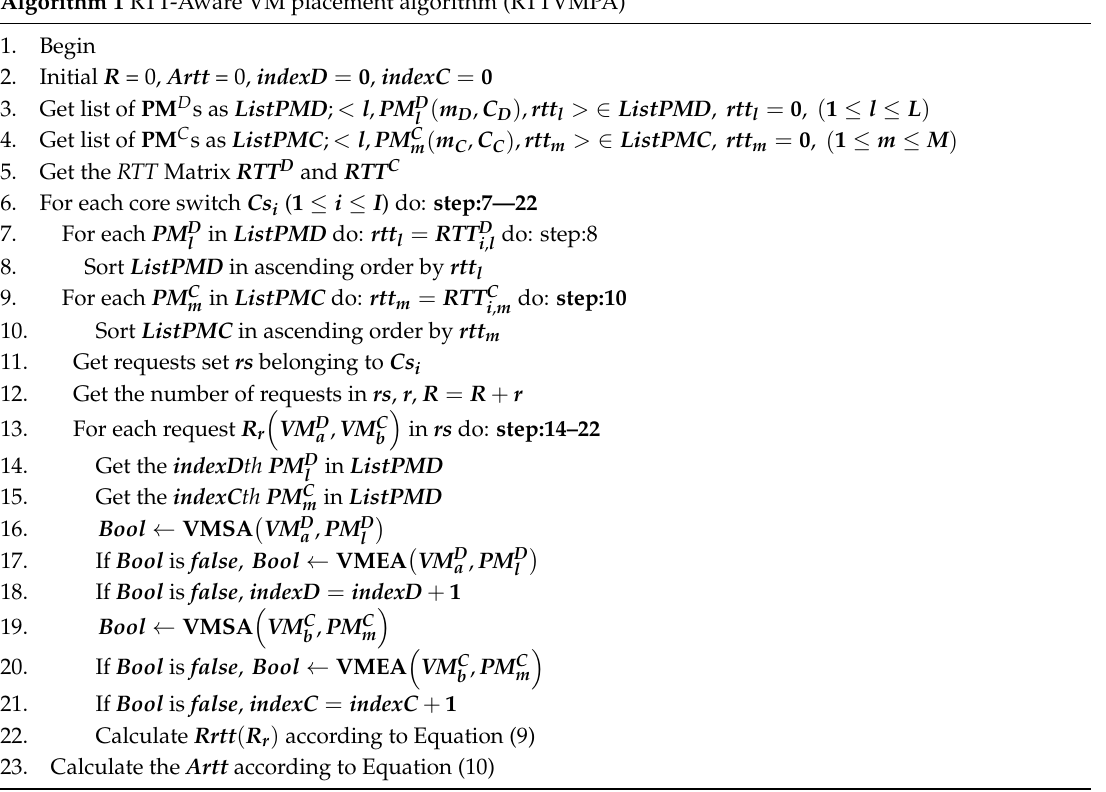
Algorithm 1 RTT-Aware VM placement algorithm (RTTVMPA)